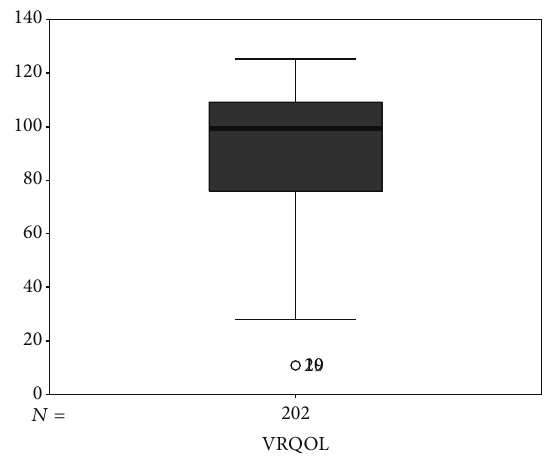
Figure 1: Boxplot showing the range of visual health-related quality of life